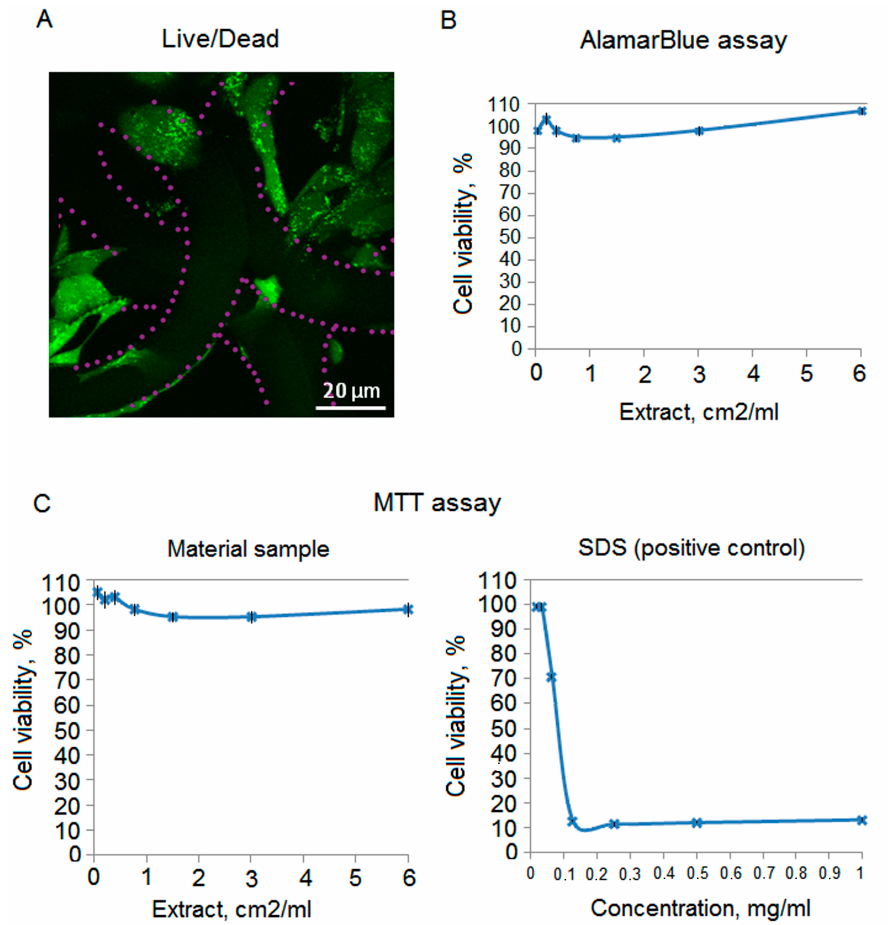
Figure 14. Cytotoxicity analysis of a crosslinked structure (sca ff old) obtained by two-photon polymerization, consisting of the modified methacrylate-containing PLA, 15 wt. % of OUDM, and 5% of a photoinitiator: ( A )—Live / dead staining (live cells—green (Calcein AM), dead cells—red (propidium iodide), violet dots—sca ff old). Confocal microscopy; ( B )—AlamarBlue assay; ( C )—MTT assay. SDS is used as a positive